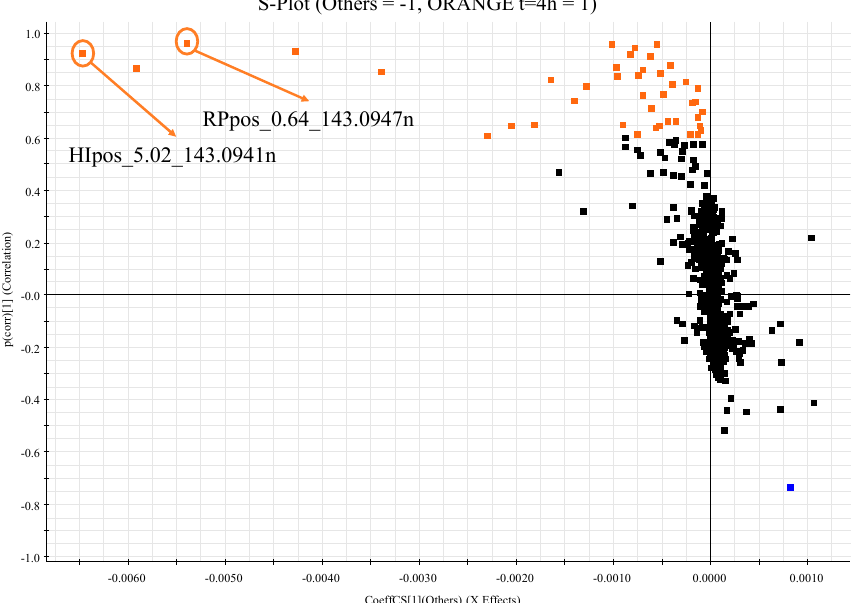
Figure 3. S-Plot from the OPLS-DA where features with repeated measures ANOVA p -value ≤ 0.05 are represented. Tentative markers with a P[corr] higher than 0.6 are highlighted in orange and lower than − 0.6 in blue.